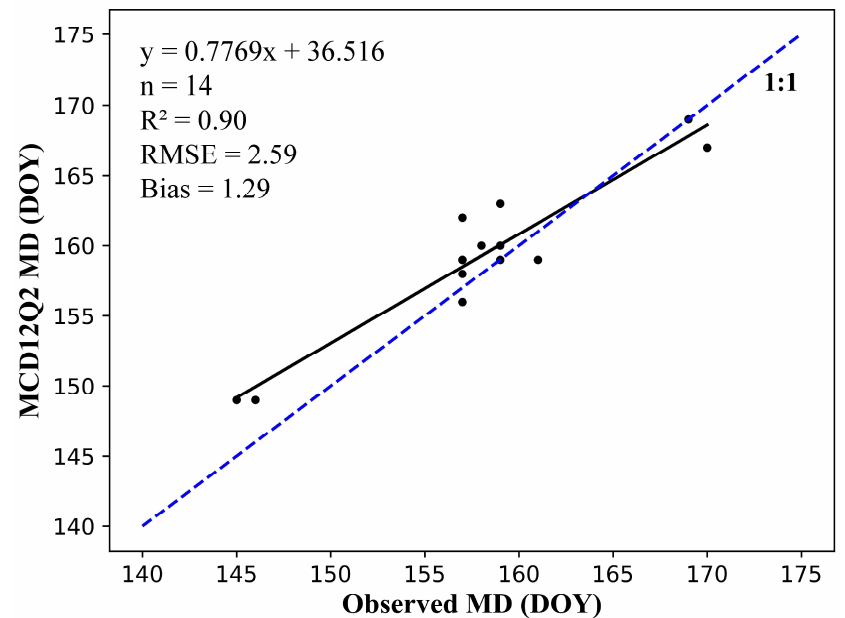
Figure 3. The consistency of ground observed data and MCD12Q2 data.